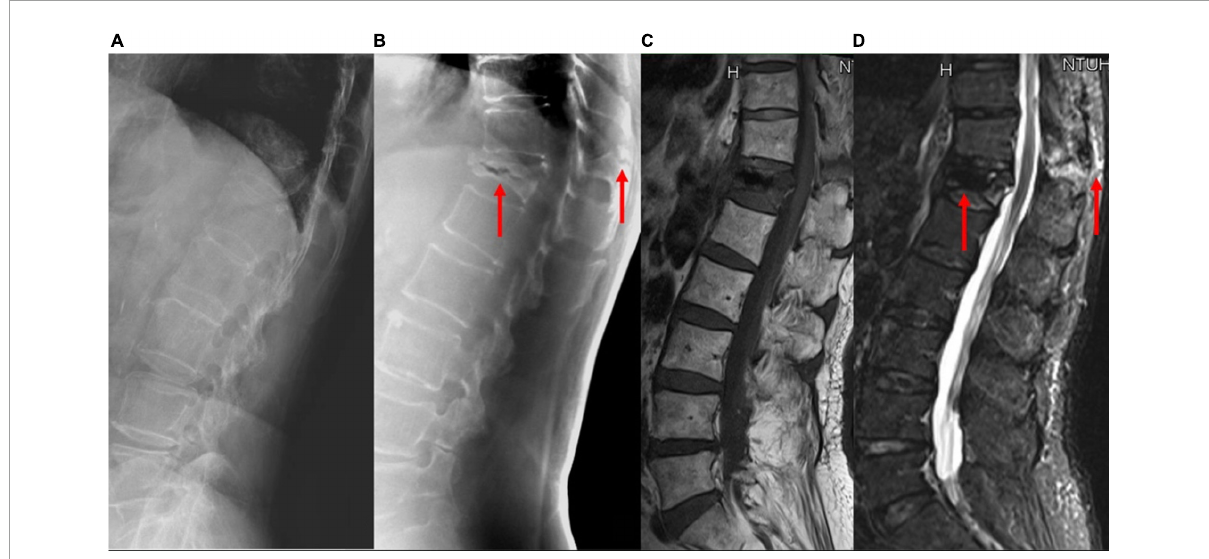
FIGURE4 A patient with acute VCF at the T-L junction. The bony details of the fracture and the adjacent vertebral levels are ruined by the abrupt density transition from the lungs to the abdomen and the decreased bone mineral density on (A) lateral radiographs; (B) tomosynthesis; (C) T1-weighted MRI, and (D) short tau inversion recovery MRI images clearly show the fracture involving the anterior and posterior vertebral edges and the spinous process (arrows). VCF, vertebral compression fracture; T-L, thoracolumbar; MRI, magnetic resonance imaging.